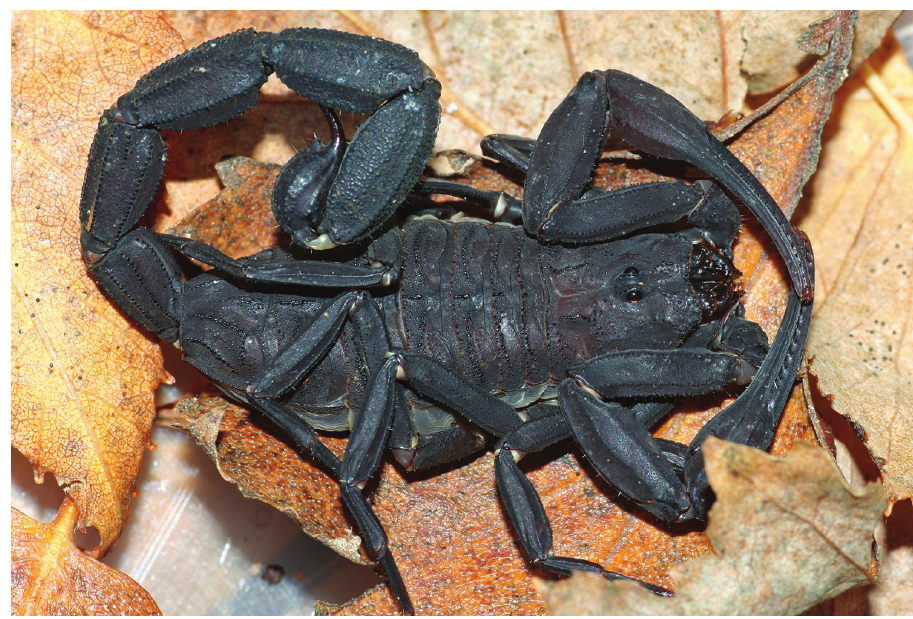
Figure 12. Tityus obscurus , adult female from